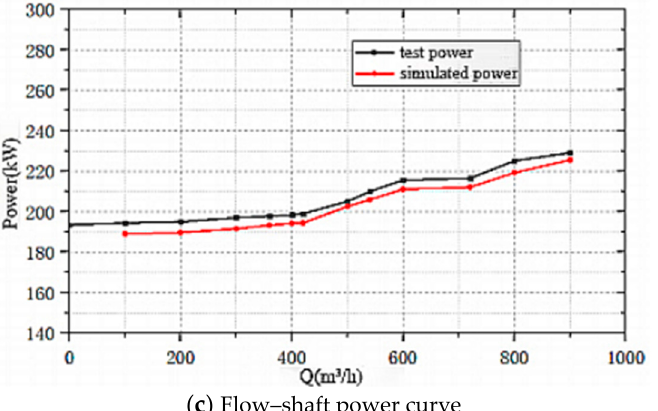
Figure 4. Performance curves of the mining pump under different flow conditions.